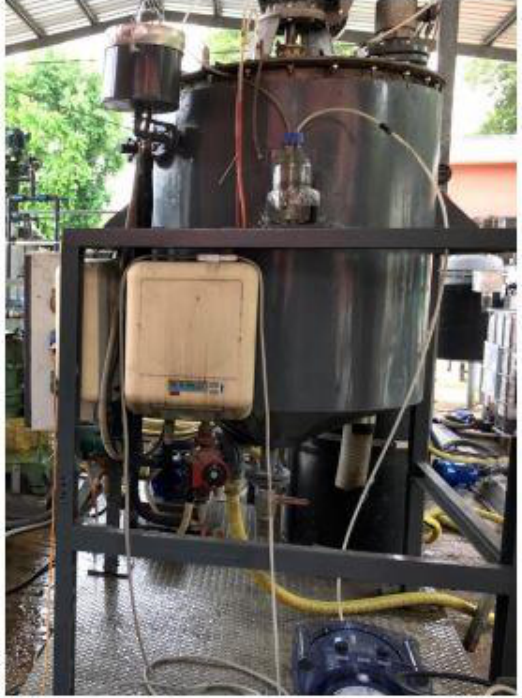
Figure 3. Fermenter of pilot plant.